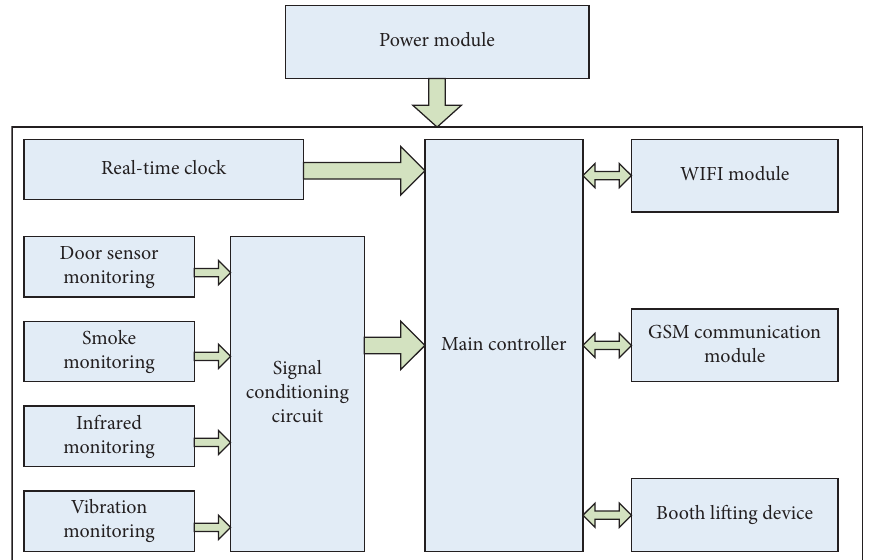
Figure 2: Hardware block